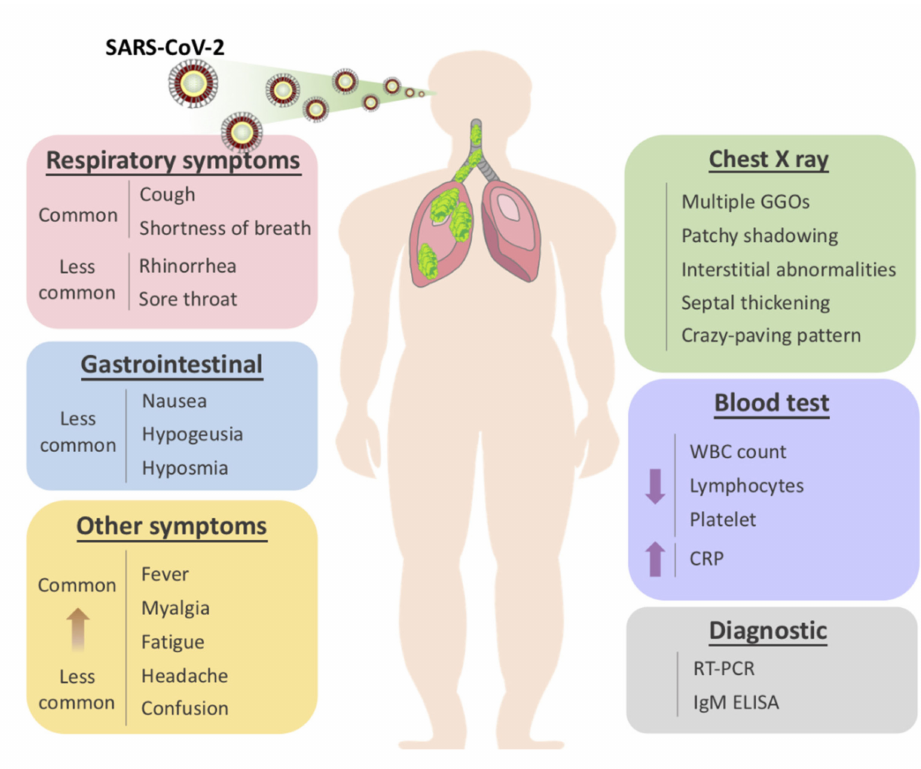
Figure 1. Overview of symptomatic, radiological and laboratory characteristics of